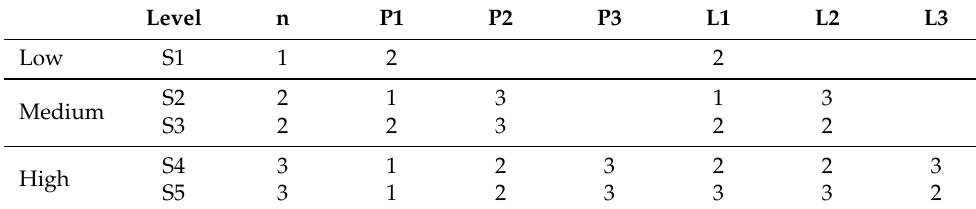
Table 4. Frame-Freezing parameters. n: Number of events; P[1,2,3]: start, middle, end; L[1,2,3]: 1, 2, 4